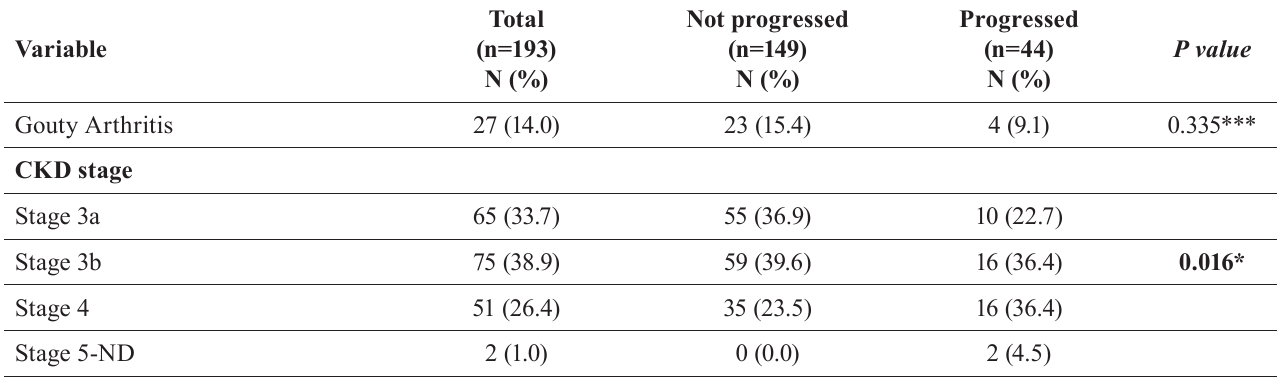
TABLE I - S ociodemographic and clinical characteristics of patients with Chronic Kidney Disease at baseline, attended between 2014 and 2016 at the Municipal Nephrology Outpatient Clinic in Divinópolis (MG), Brazil (n = 193)